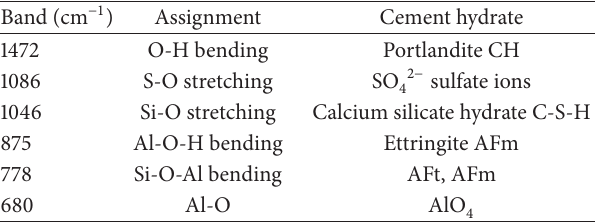
Table 9: Characteristic FTIR bands before chemical